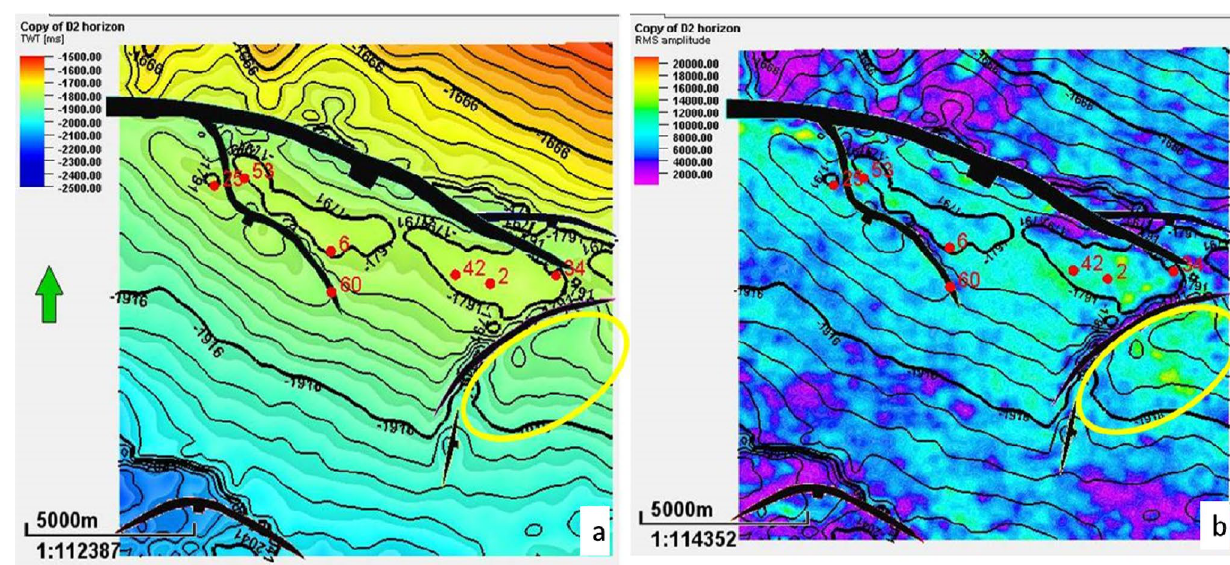
Fig. 5 a Structural map of D2 reservoir, b an overlay of amplitude map of D2 reservoir on the structural map for prospect